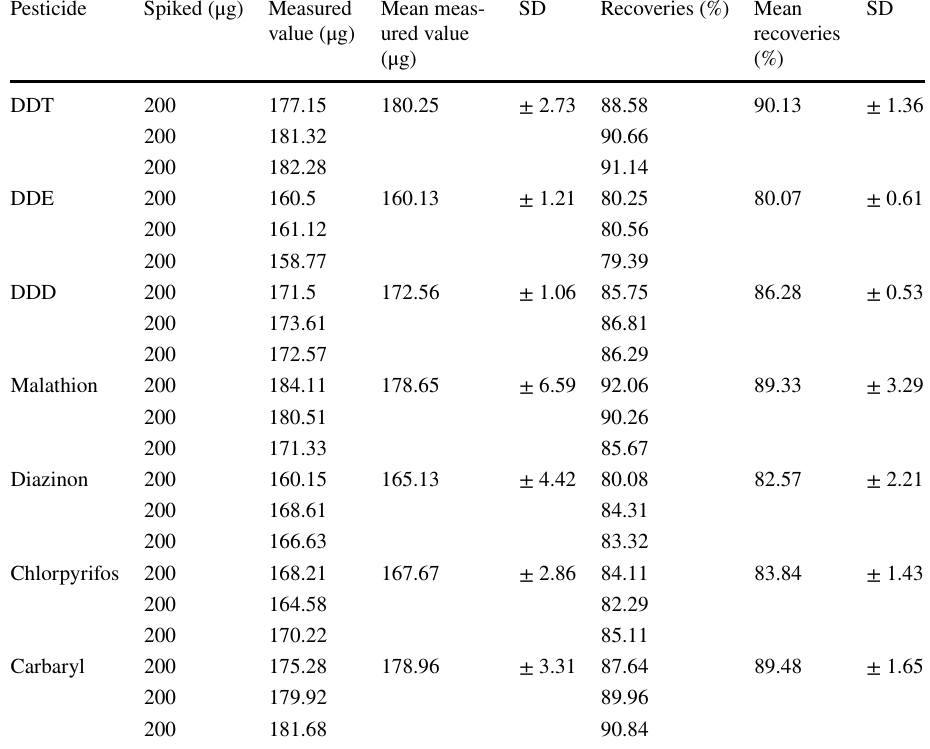
Table 1 Results of recovery